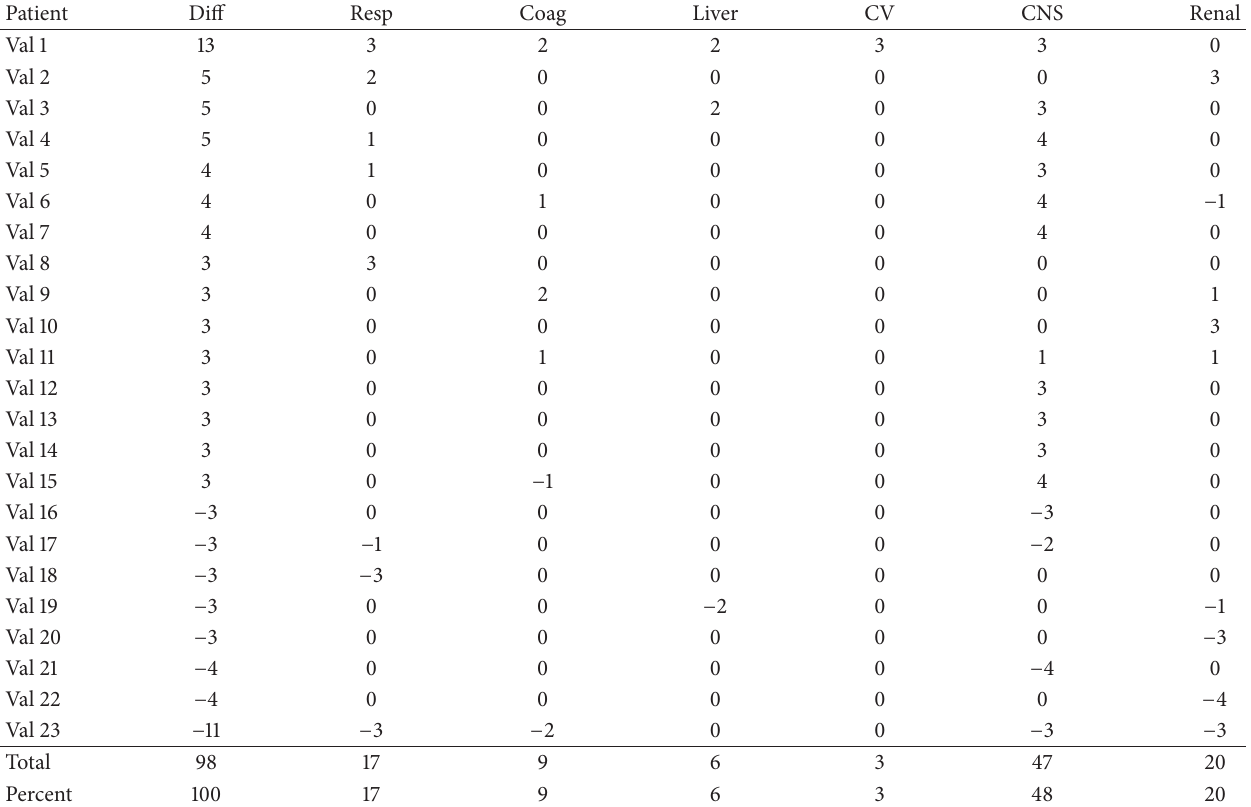
Table 3: Validation cohort subset: difference (manual score − automatic score) greater than two. Difference in component scores is also included. Total represents the sum of the absolute value of the